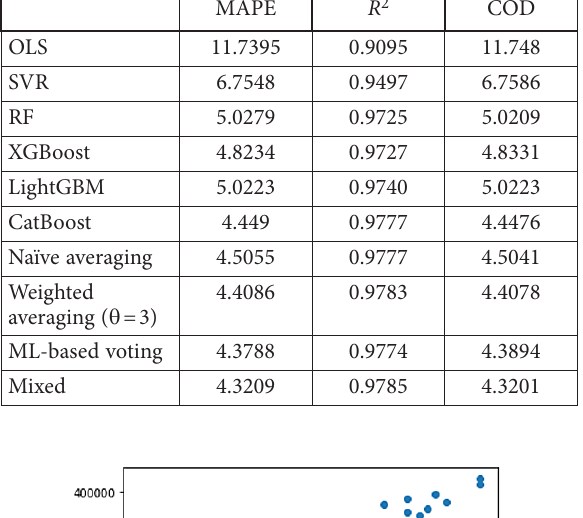
Table 7. Accuracy measurements: second-stage analysis